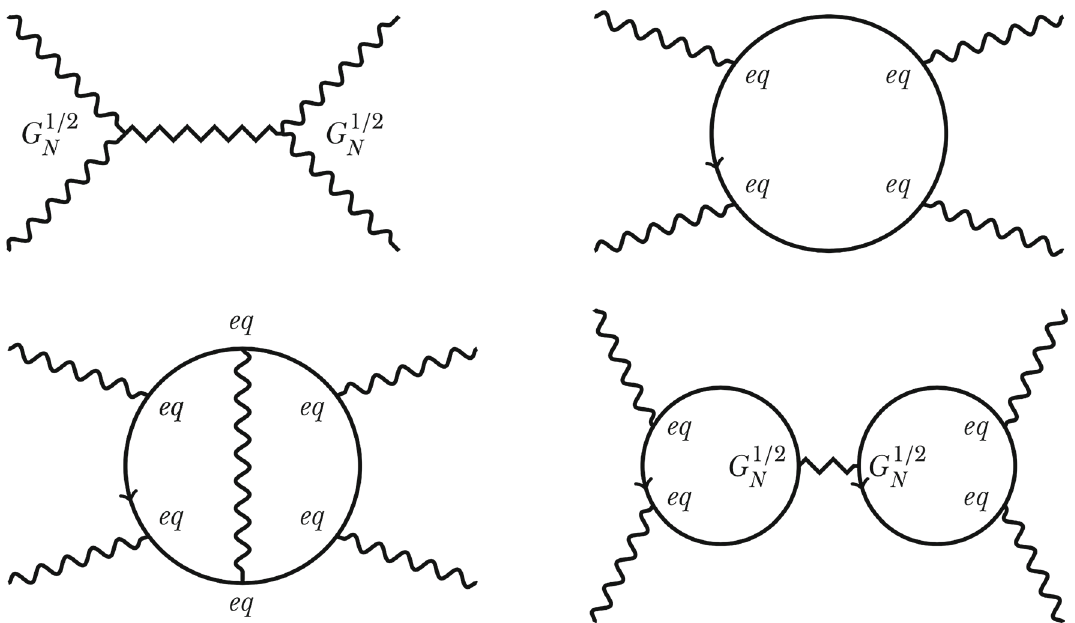
Fig. 5 Contributions to four-photon scattering: at tree level, through graviton exchange at order G N ; at one loop, through electromagnetic inter- actions with charged particles at order e 4 ; at two loops, from one diagram of order e 6 and one of order e 4 G N (cid:19) (cid:18)(cid:20) (cid:20) 2 ∼ Q ( E ) 6 , we see q 2 q 6 ∼ Q ( E ) 7 and Writing